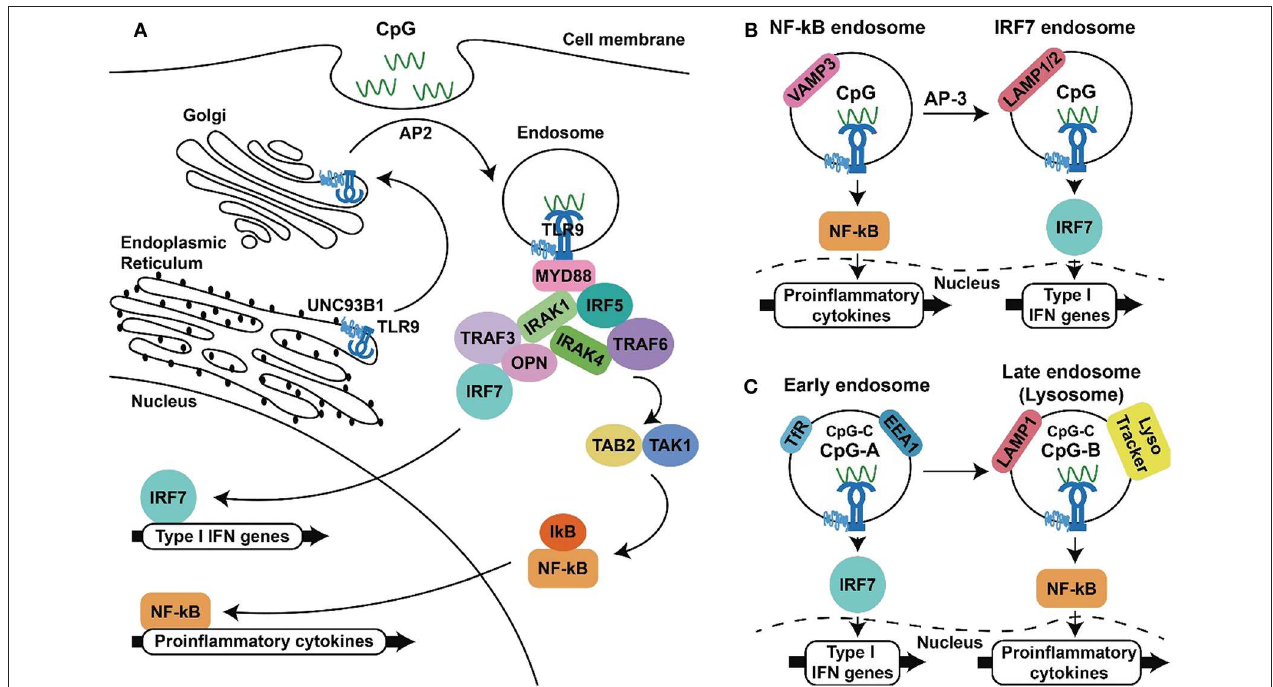
FIGURE 1 | TLR9 signaling to produce inflammatory cytokines and type I IFNs. (A) TLR9 synthesized in the endoplasmic reticulum traffics through the ER, Golgi to endosome with the aid of UNC93B and AP2, where TLR9 interact with CpG-ODN, recruits MyD88 and downstream signaling molecules to activate NF- κ B and IRF-7, resulting in the production inflammatory cytokines and type I IFNs (B,C) . Two proposed models for the spatiotemporal activation of NF- κ B and IRF-7 at different type of endosomes. In the first model, TLR9 triggers NF- κ B activation from the VAMP3 + endosomal compartments within minutes after activation and initiates IRF-7 activation in the LAMP1/2 endosomal compartment in 30min to hours (B) . In the second model in plasmacytoid dendritic cells, class A CpG-ODNs activate IRF-7 to produce type I IFNs from the EEA1 + , TfR + early endosomes. In contrast, class B CpG-ODNs activate NF- κ B for inflammatory cytokine production in LAMP1 + and lysoTracker + late endosomes/lysosomes (C) . The capability of class C CpG-ODNs to activate production of type I IFNs and inflammatory cytokines is in between the capabilities of CpG-ODNs in class A and class